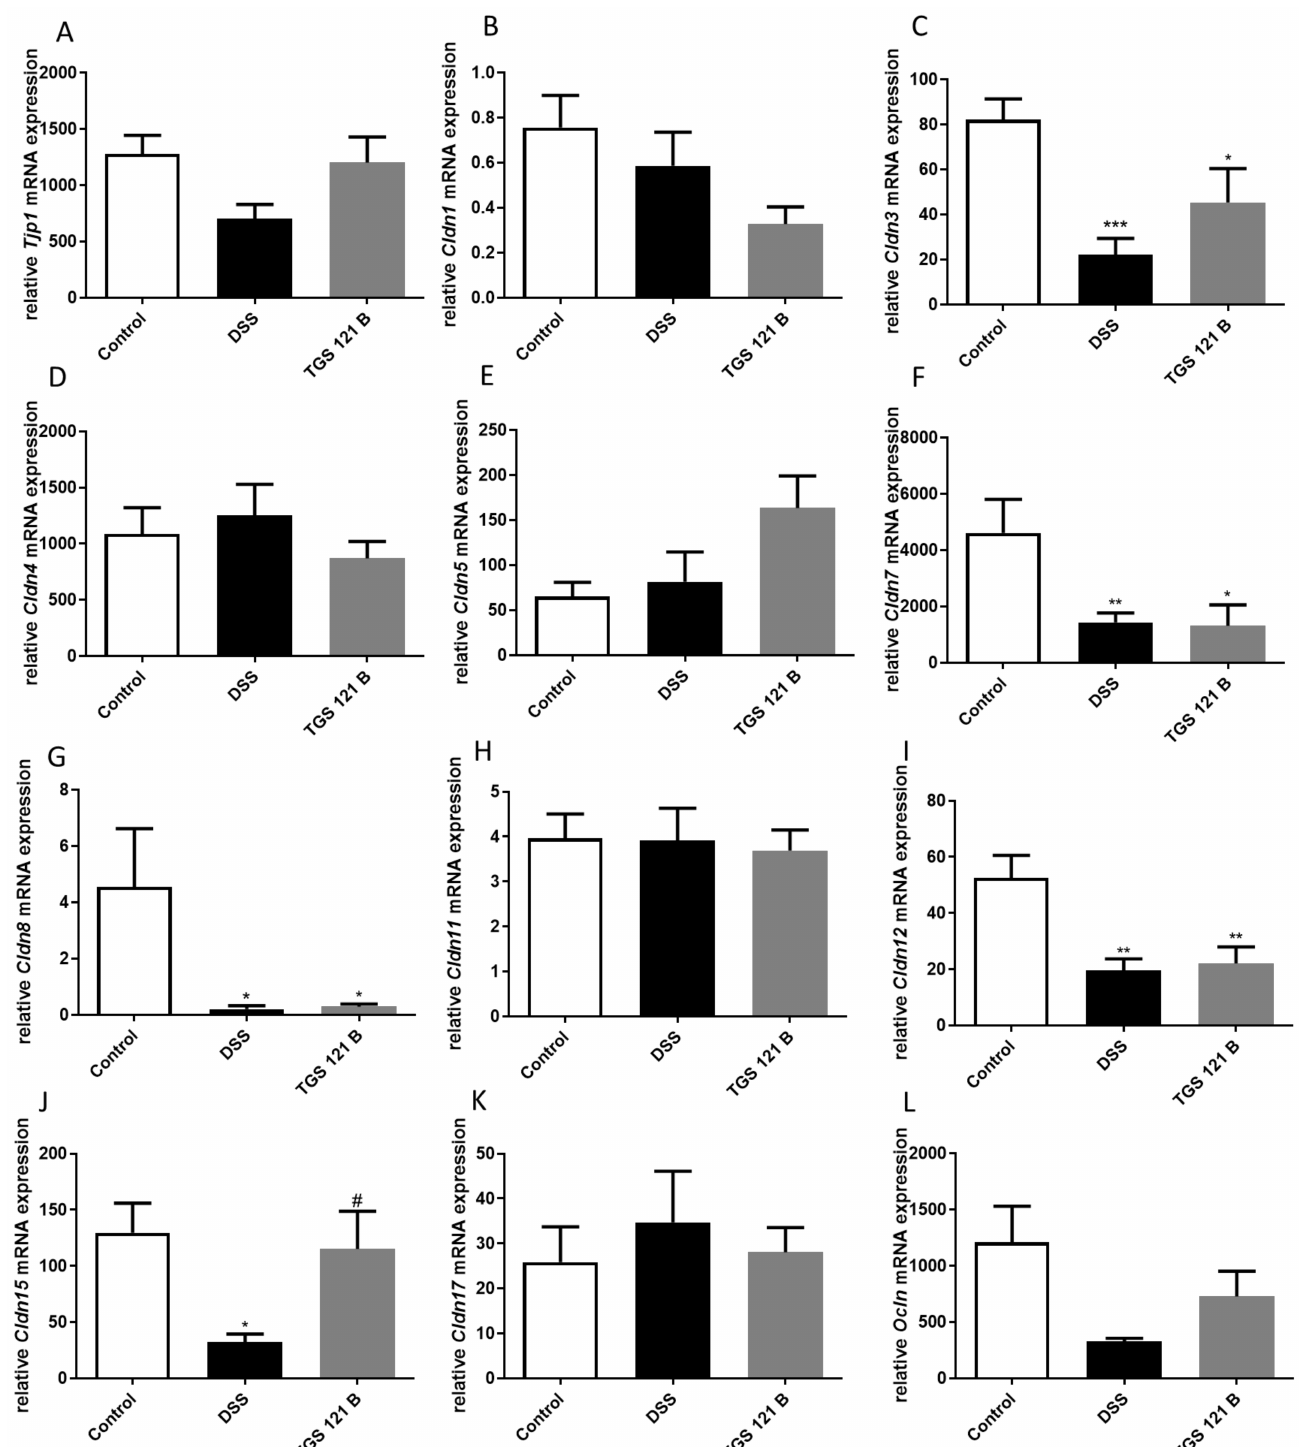
Figure 4. The influence of DSS colitis induction and TGS 121 treatment on the expression of intestinal wall function proteins for control, DSS-only treated mice, and mice with DSS-induced colitis treated with TGS 121 at 16.8 µ g/kg (TGS 121 B):